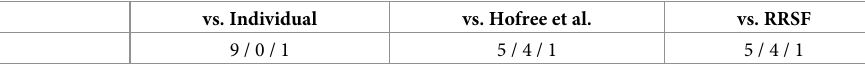
Table 1. Win/Tie/Loss counts of PRER against competing methods. PRER is compared against each model over 100 trained models, where each model is trained on a different train/test split. The comparisons are based on one-sided Wilcoxon signed rank test with BH multiple hypothesis test correction at the significance level of 0.05. The Hofree et al. method is the network propagation algorithm [7]. RRSF stands for reweighted random survival algorithm by Wang and Liu